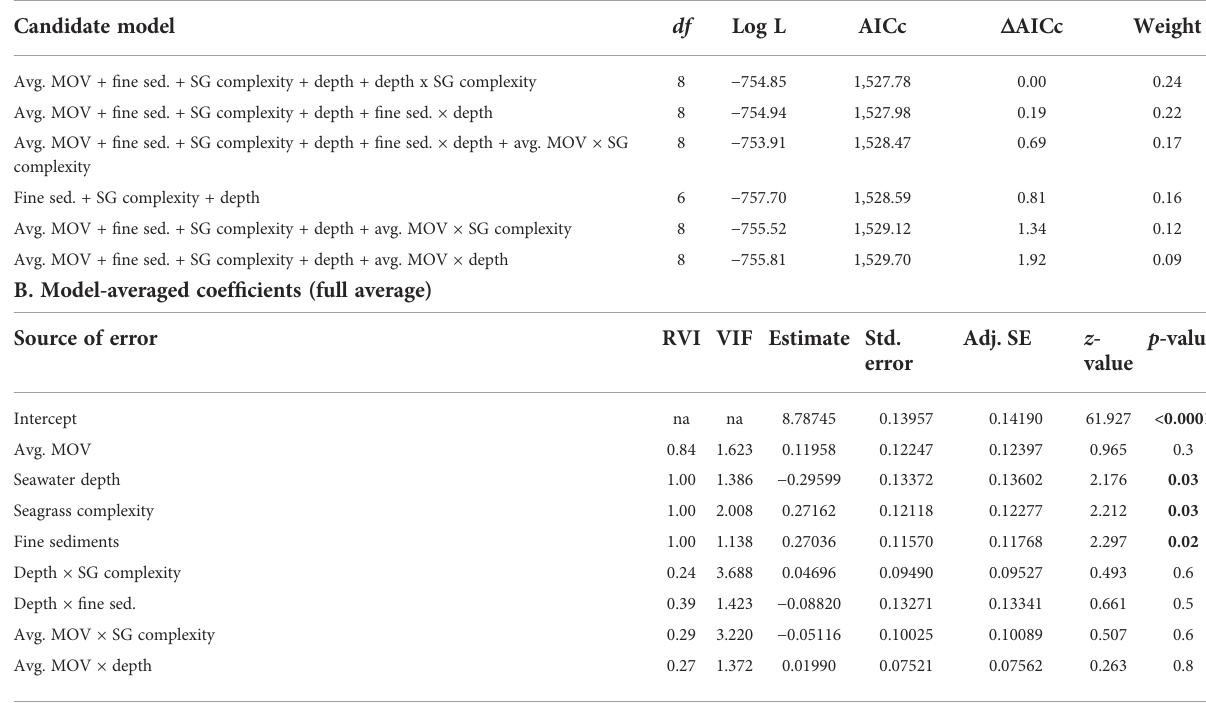
TABLE 4 Summary of alternative candidate Generalized Linear Mixed Models (Gamma, log link function) with D AICc<2 (A) and their model- averaged coef fi cients (B) for biophysical predictors of regional sediment organic carbon (C org ) content of seagrass-vegetated sublocations along the Baltic Sea coast of